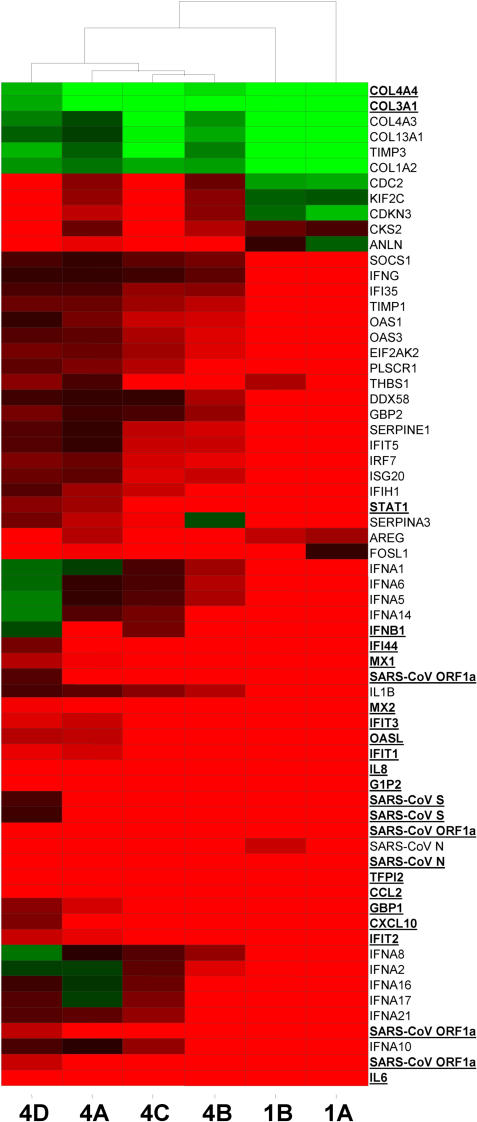
Immune Response, Cell Cycle, and Lung Repair Genes with Strongly Induced or Reduced ExpressionA selection of genes, involved in the immune response, cell cycle, or lung repair processes, that showed an absolute fold change > 5 and p < 0.0001 in both day 1 animals and/or in at least two of the four day 4 animals was made. Genes with an absolute fold change > 5 in both day 1 animals and in at least two of the four day 4 animals are indicated with bold, underlined text. A full summary of genes that show an absolute fold change > 5 and p < 0.0001 after SARS-CoV infection is given in Figure S2.